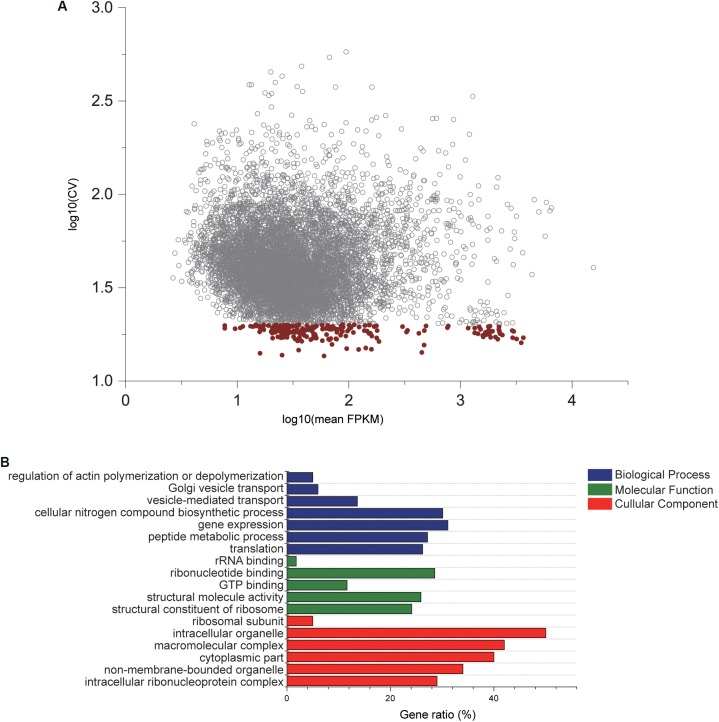
Gene expression characteristics and GO enrichment analysis of candidate reference genes. (A) Scatterplot of the coefficient of variation × 100% (CV%) against mean expression values (FPKM) after log10 transformed based on RNA-Seq data. Each circle represents a gene, and red circles are 196 genes with CV lower that 20%. (B) Significantly enriched GO terms by GO enrichment analysis conducted with 196 genes. Gene ratio is defined as the percentage of genes in the GO terms that overlaps with the gene shortlist.